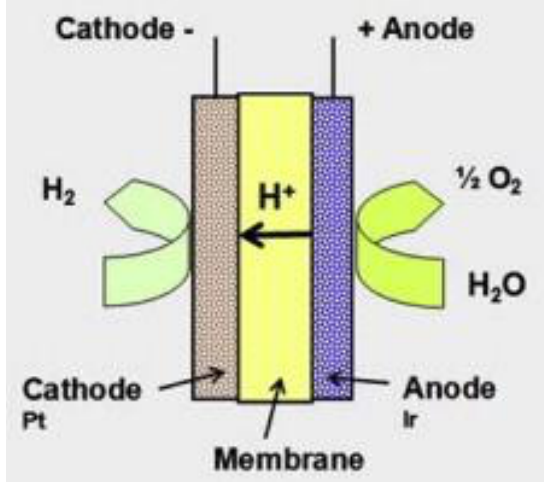
Figure 6. PEM electrolysis. Reproduced with permission from [30].